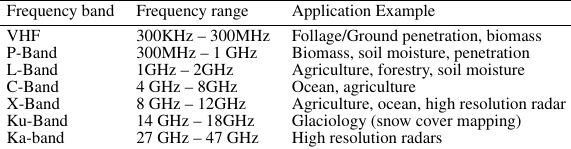
Table 1. Commonly used SAR frequency bands and their